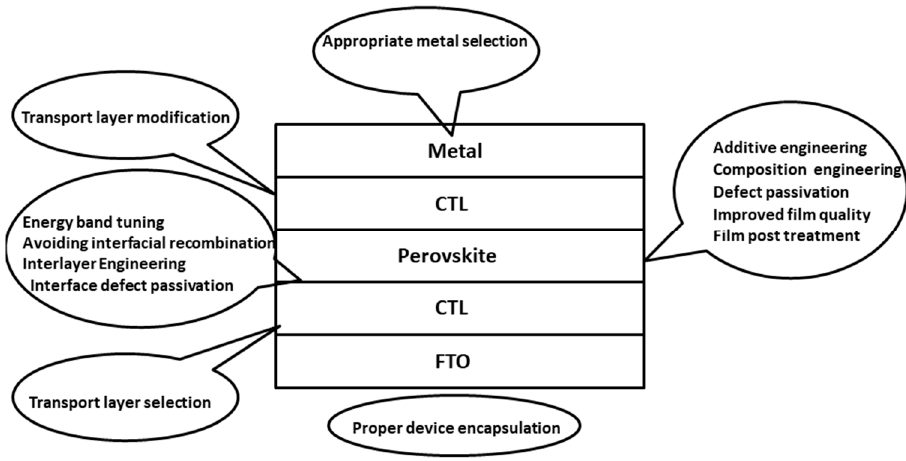
Figure 7. Various strategies to improve stability and avoid degradation in